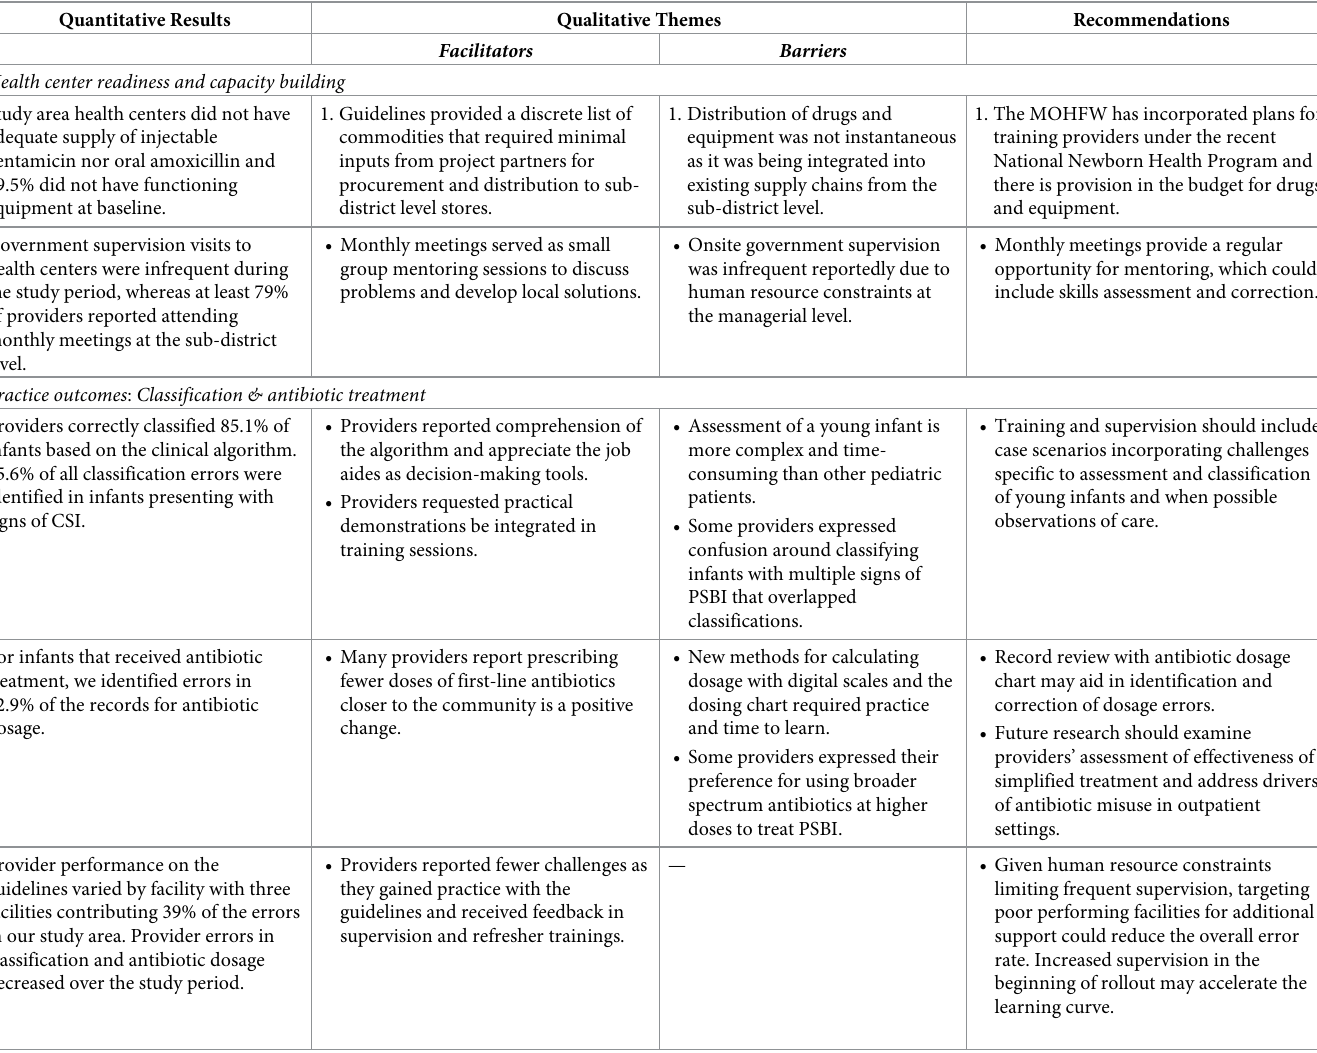
Table 6. Results of qualitative investigation into reasons for high and low values of health facility readiness indicators and practice outcomes. Quantitative